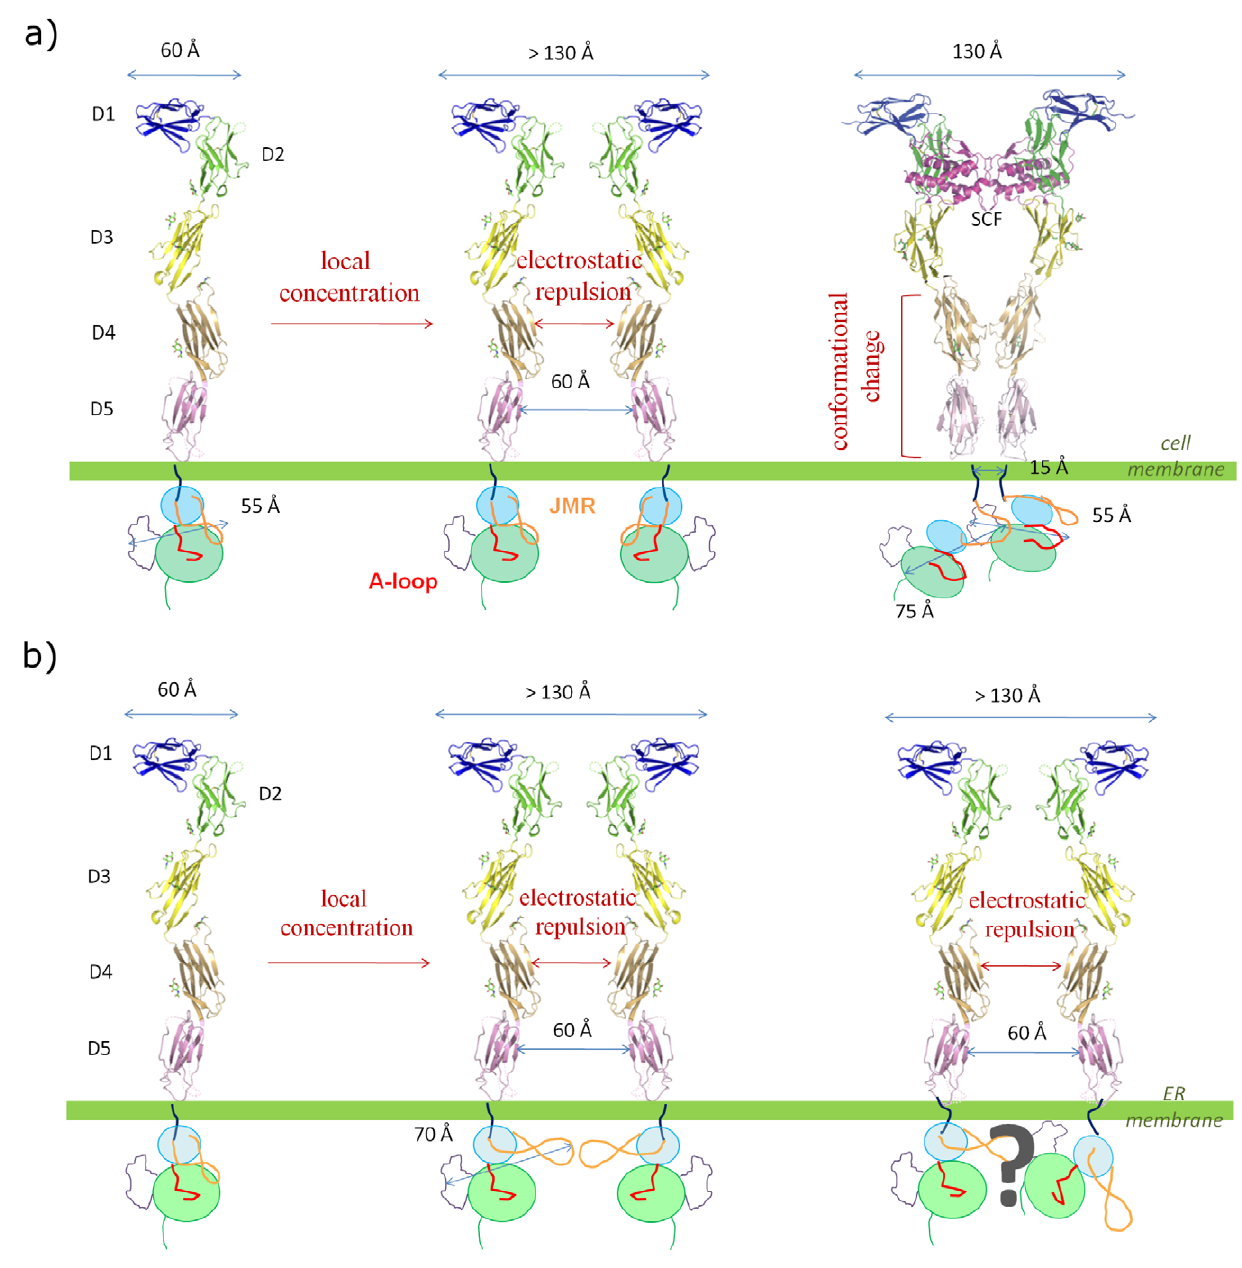
Figure 9. Schematic representation of a proposed model for wild-type and D816-mutated KIT dimerization and activation processes. ( a ) In wild-type KIT, the activation process supposedly unfolds as follows: (1) the receptor is anchored at the cell membrane in form of a monomer (PDB code 3EC8), (2) the density increases, but a minimal distance of 60 A˚ is kept between monomers due to electrostatic repulsion between domains D4 (mechanism proposed in [15]), (3) binding of SCF dimeric ligand promotes dimerization of KIT ectodomain and induces a conformational twist that brings the domains D5 of the two monomers in contact, (4) transmembrane helices of the two monomers are as close as 15 A˚ to each other, permitting dimerization sans transphosphorylation of KIT cytoplasmic region. ( b ) The D816V mutant is activated and triggers signaling pathways when anchored to the Endoplasmic Reticulum (ER) membrane, so that it does not meet the extra-cellular SCF ligand (mechanism proposed in [43]). Electrostatic repulsion between domains D4 of KIT monomers still holds, preventing dimerization and conformational twist of the ectodomain. However, our results show that JMR is allowed more freedom of movement and can spontaneously extend from PTK. Based on our NMA-displaced conformations, we can evaluate at about 20 A˚ at least the increase in the longest dimension of the protein. This increase could be sufficient to overcome the gap imposed by D4-D4 electrostatic repulsion and promote spontaneous dimerization of KIT cytoplasmic region, explaining why the D816V mutant functions as a dimer. The model of mutant dimer was drawn based on the lowest-energy complex predicted by RosettaDock (communicated in [115]) using KIT 4-A˚ conformation displaced along normal mode 17 {2531-ps} .